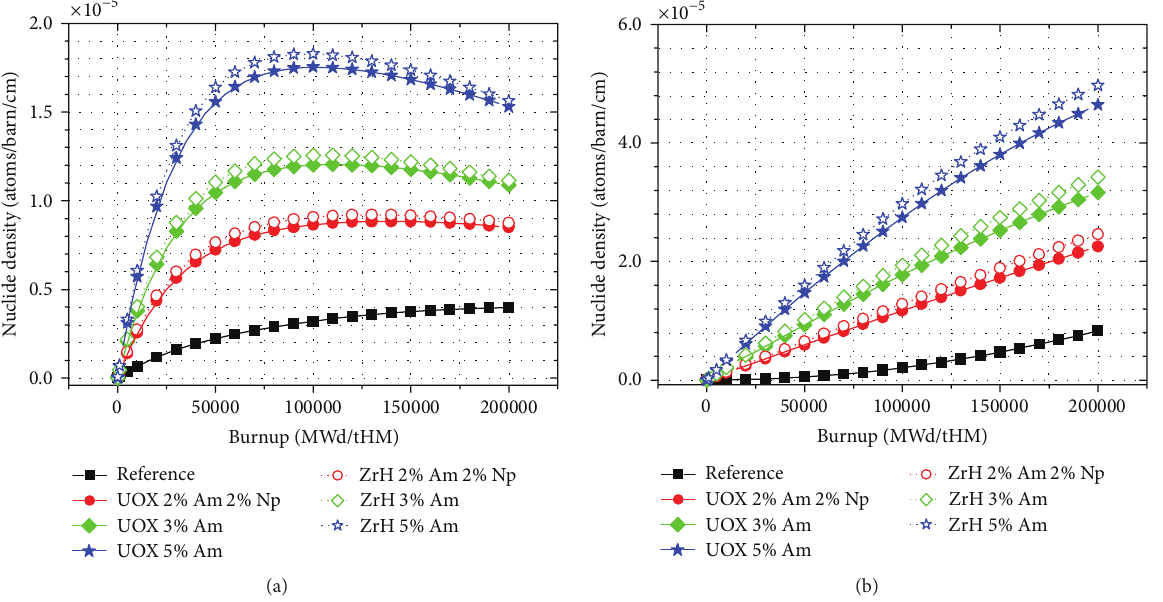
Figure 8: Change in the Curium-242 (a) and the Curium-244 (b) content over burnup for the case with and without moderation.